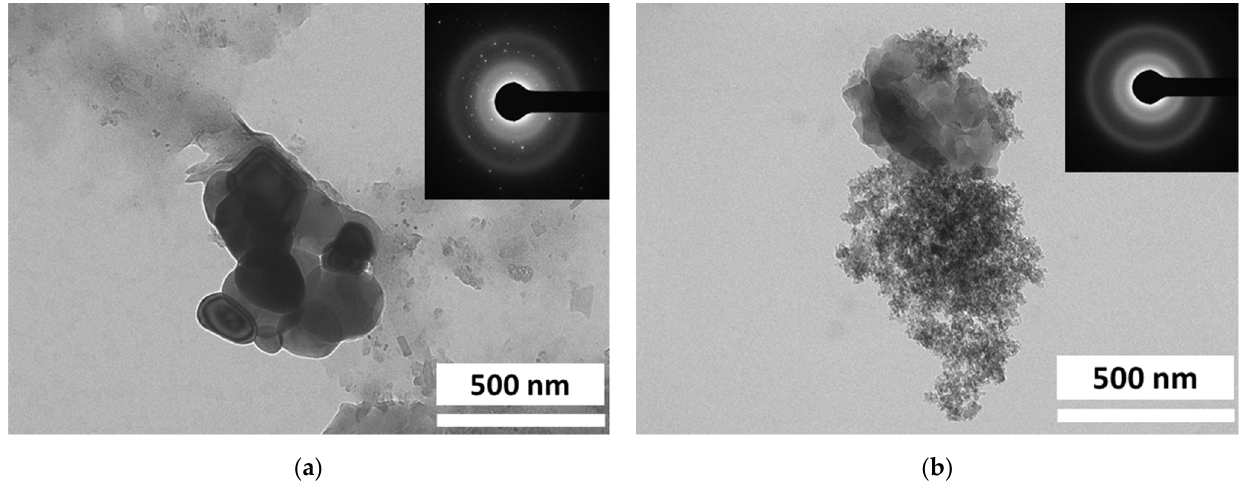
Figure 3. TEM images and SAED pattern of ( a ) silica and ( b ) silica–lignin hybrid.